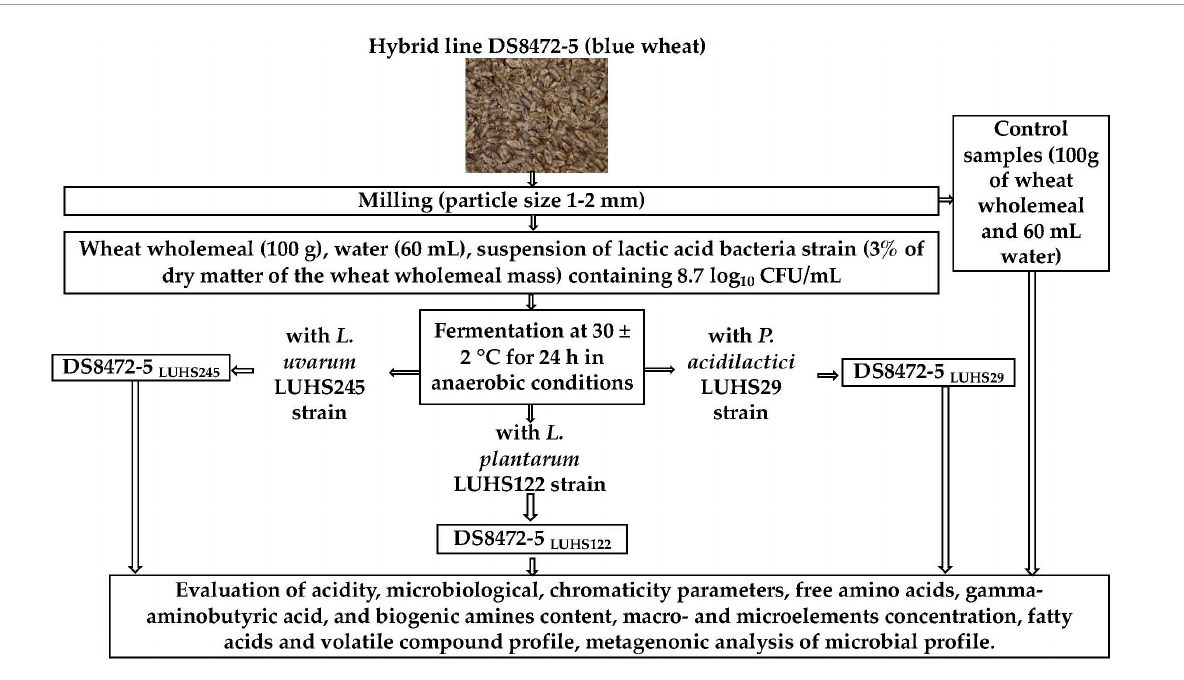
FIGURE1 Schematic representation of the experimental design (DS847 2-5 —new cultivar of blue wheat; CFU, colony forming units; LUHS29, treated with Pediococcus acidilactici LUHS29; LUHS245, treated with Liquorilactobacillus uvarum LUHS245; LUHS122, treated with Lactiplantibacillus plantarum